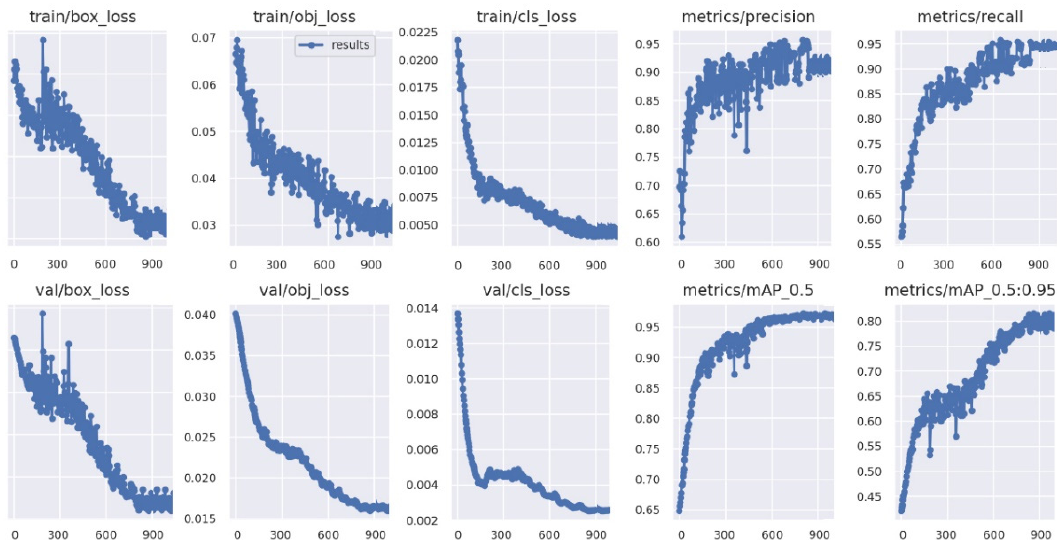
Figure 11. Schematic diagram of the calculation of the size of the prediction box.